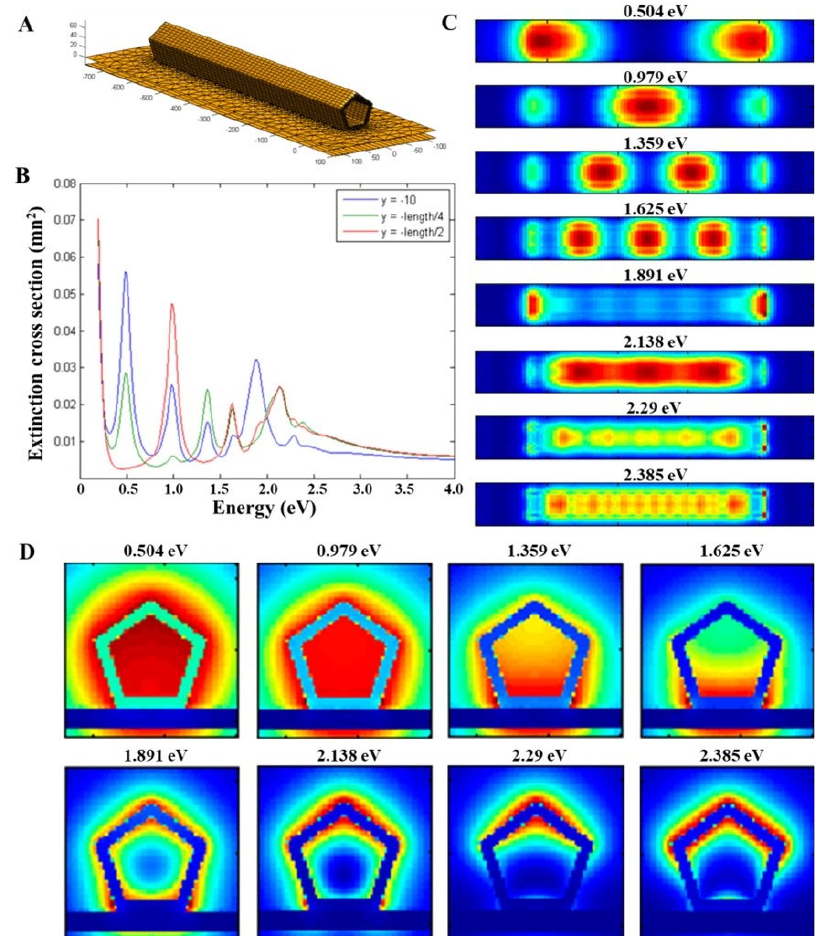
Figure 3. BEM simulations of the completely hollow AuAg nanotube. ( A ) Structural model of the BEM-simulated AuAg nanotube with a length of 665 nm, a diameter of 84 nm, and 10 nm thick walls standing on a 15 nm thick Si 3 N 4 substrate. ( B ) Simulated local EEL spectra obtained at the tip (in blue), at a quarter of the length (at ~166 nm, in green), and at the center (at 332.5 nm, in red) of the AuAg nanotube. ( C ) BEM-simulated plasmon maps of eight different modes located at 0.504 eV, 0.979 eV, 1.359 eV, 1.625 eV, 1.891 eV, 2.139 eV, 2.29 eV, and 2.385 eV from the in-plane view. ( D ) BEM-simulated plasmon maps of the same modes from the cross-sectional